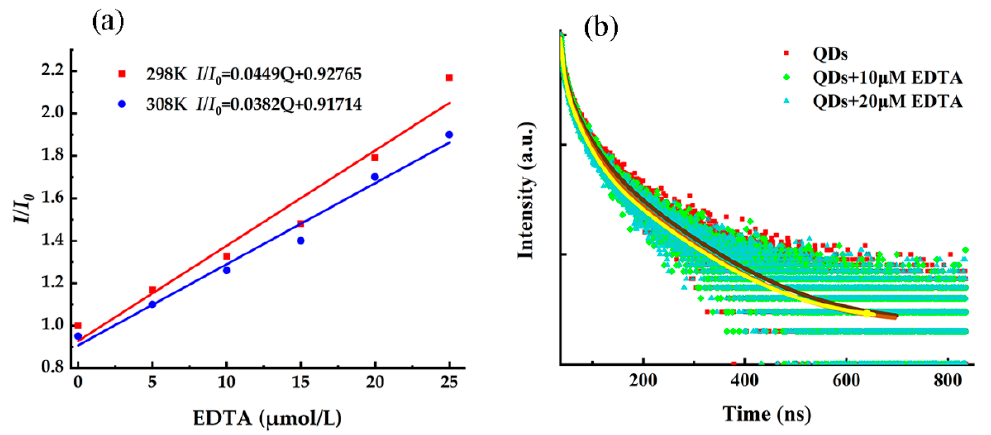
Figure 5. ( a ) Stern–Volmer plot for CdSe/CdS QDs system at 298 K and 308 K quenched by EDTA, and ( b ) fluorescence lifetime of the systems of QDs, QDs + 10 µmol/L EDTA, and QDs + 20 µmol/L EDTA.